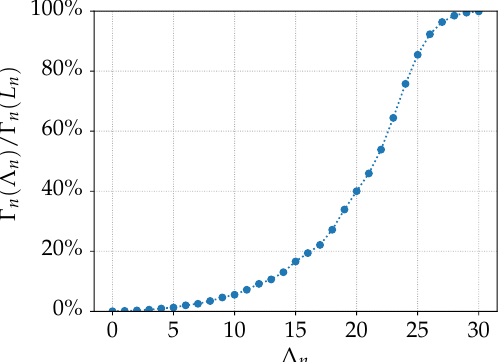
Figure 4. Typical sigmoid behavior of the cumulative power spectra ratio Γ n ( Λ n ) / Γ n ( L n ) for increas- ing Λ n . A sufficient value for Λ n is reached when this ratio is at least